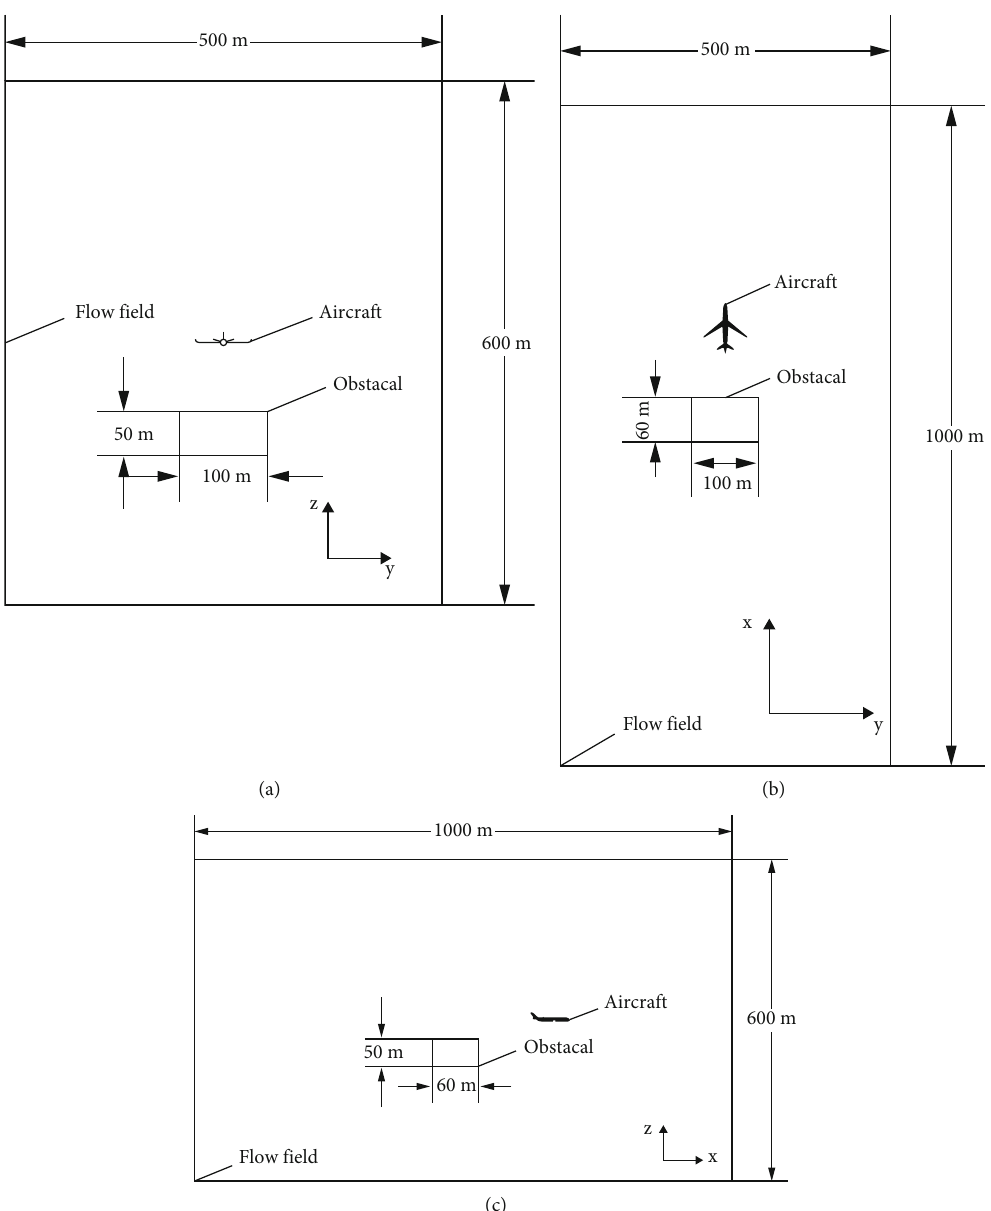
Figure 1: Three views of computational domain: (a) main view, (b) top view, and (c) left